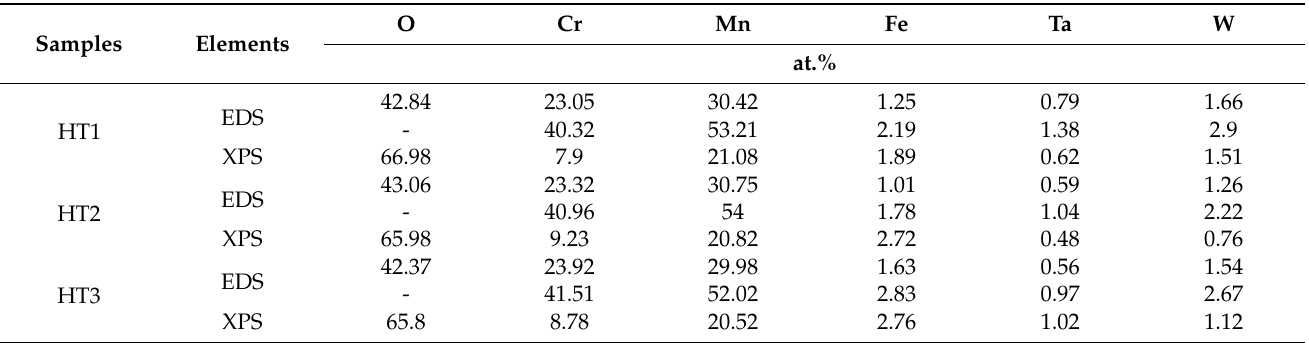
Table 3. The contents of each element on the surfaces of HT1, HT2 and HT3, as detected by EDS and XPS.